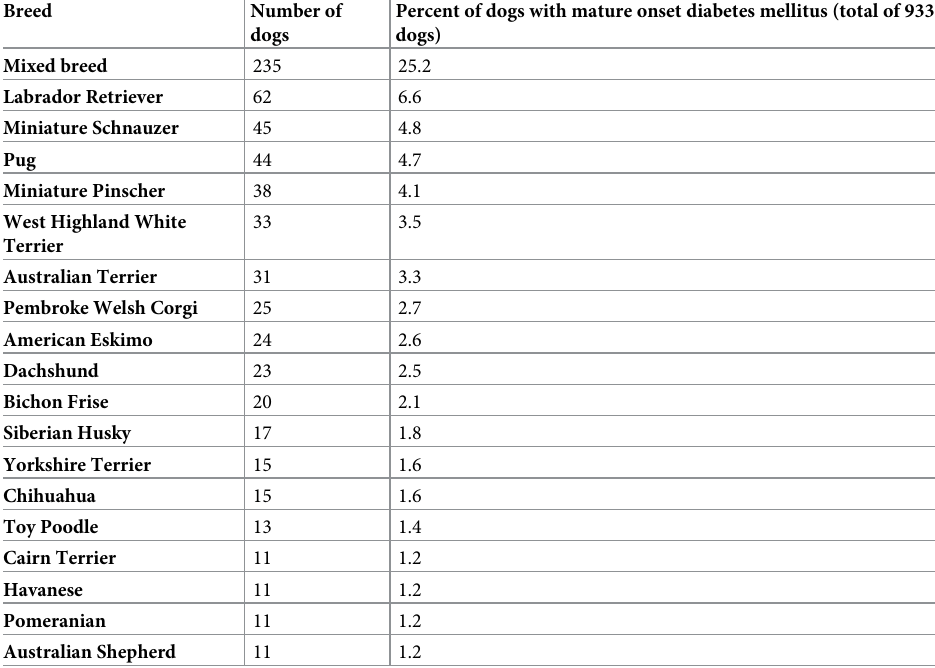
Table 2. Breeds of dogs with mature onset diabetes mellitus represented in the study by > 10 dogs. Breed Number of Percent of dogs with mature onset diabetes mellitus (total of 933 dogs dogs) Mixed breed 235